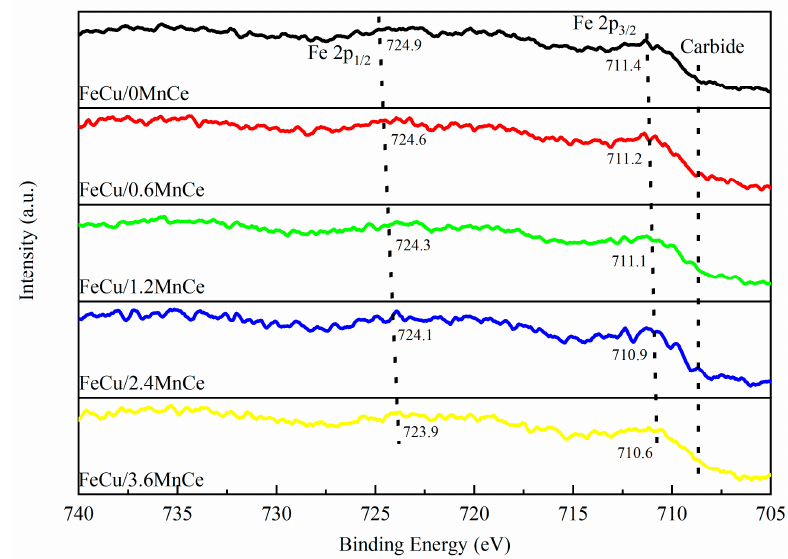
Figure 5. Fe 2p XPS spectra of catalysts after reaction.